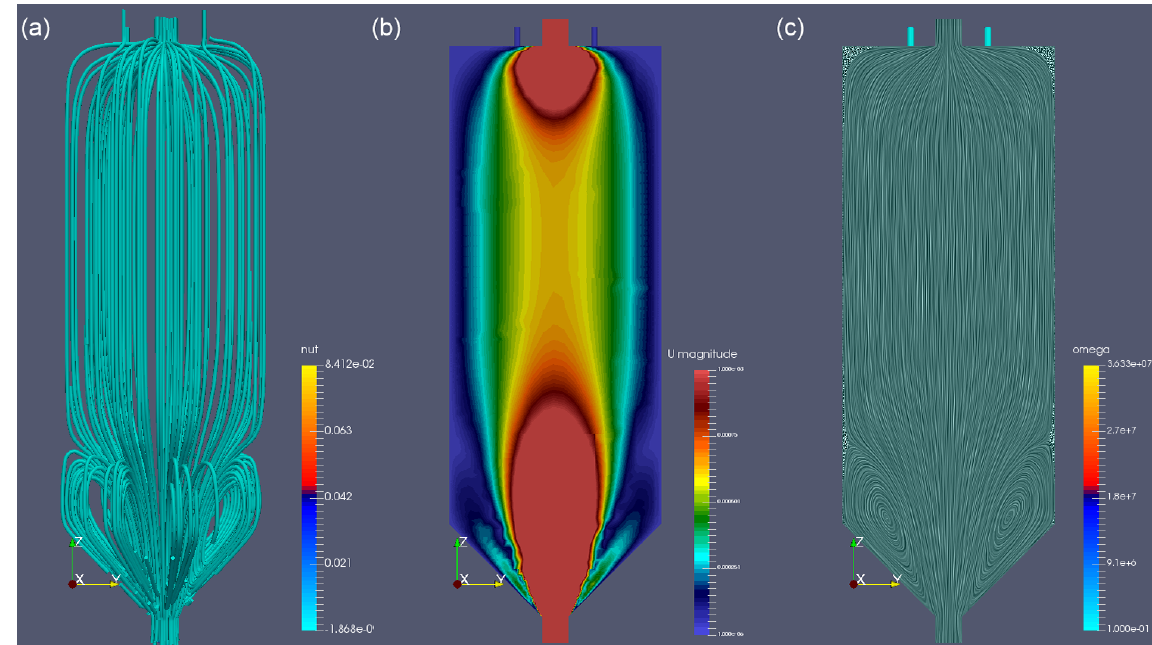
Figure 6. CFD analysis on the effect of inlet cone and peripheral outlets on fluid flow. All figures represent a visualization of the flow field, with color scales representing (from left to right): kinematic viscosity, velocity, and ω . The 3-D representation in panel (a) highlights the uniformity of the recirculation